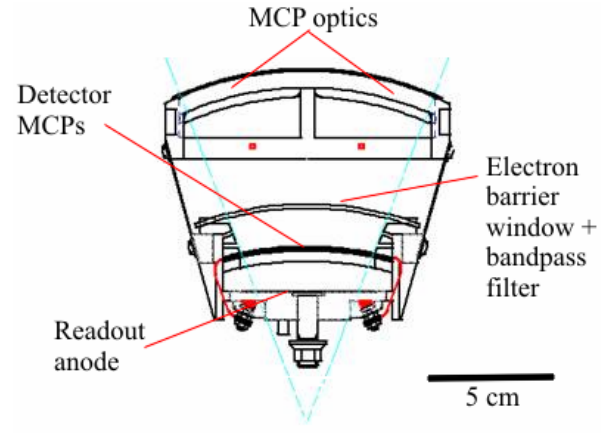
Fig. 2. WFAI module schematic. Note that planar windows and